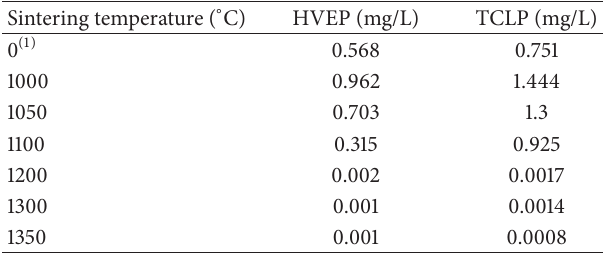
Table 3: The As leaching concentration of sintered products at different sintering temperatures.